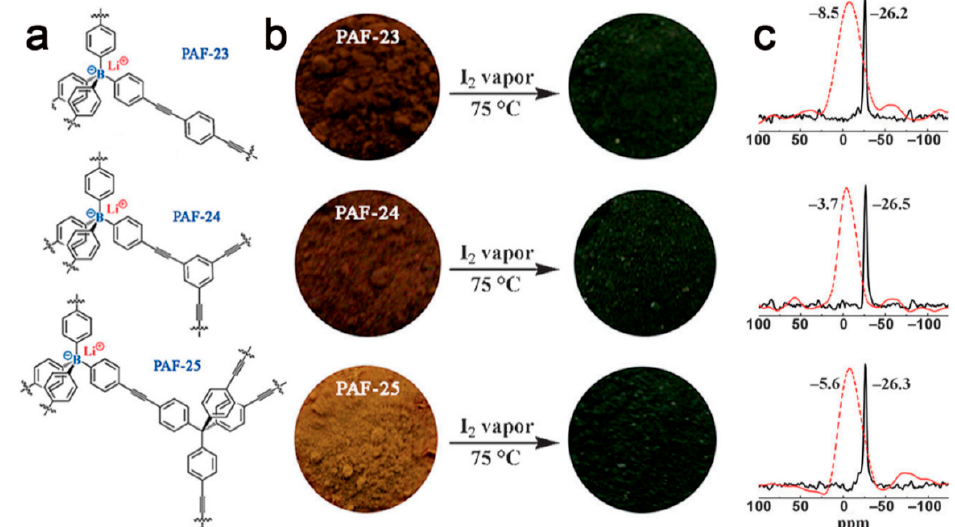
Figure 7. A schematic illustration of triphenyl borate-based porous polymers PAF-23 , PAF-24 , and PAF-25 ( a ); photographs of PAF-23 , PAF-24 and PAF-25 when adsorbing iodine ( b ); the change of solid-state 11 B NMR spectra of PAF-23 , PAF-24 and PAF-25 after adsorbing iodine ( c ). Reprinted with permission from [94]. Copyright 2015, Wiley-VCH.